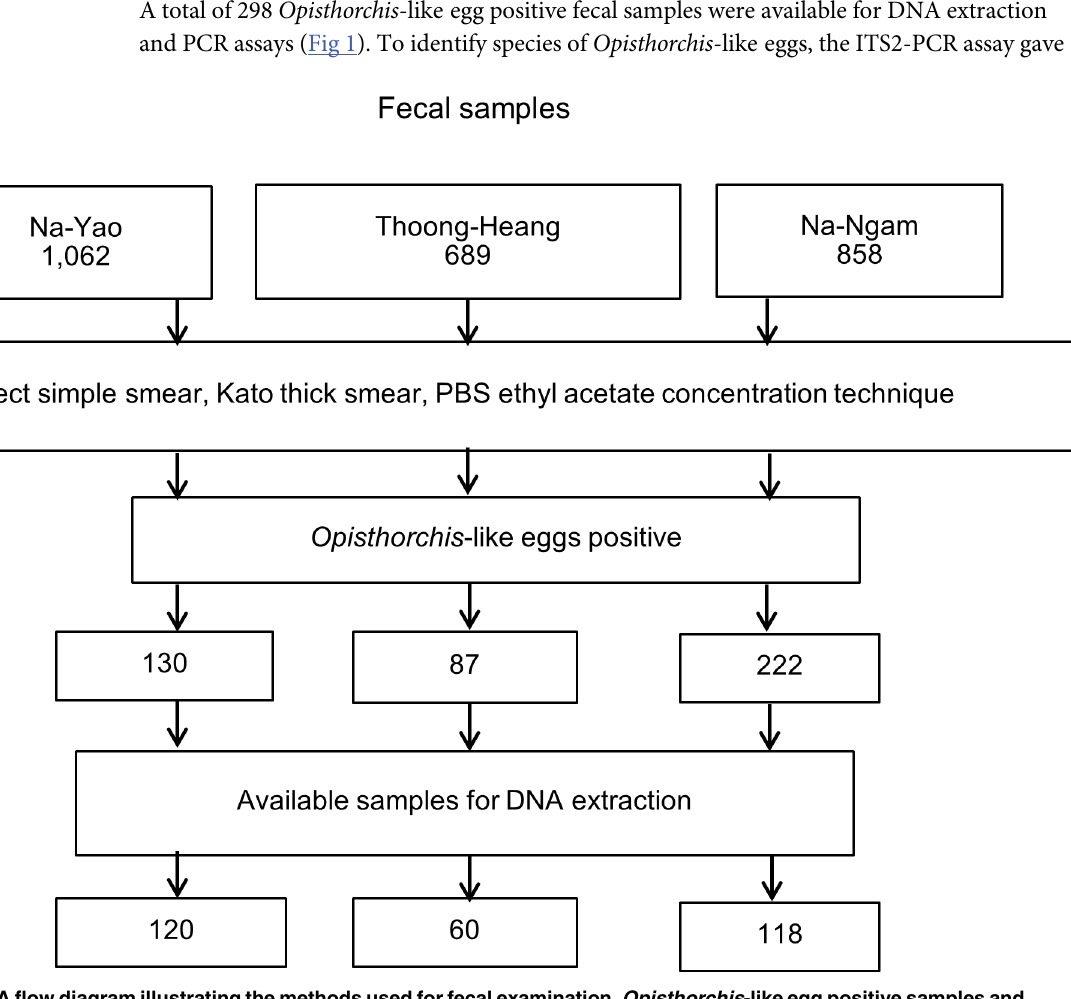
PLOS NeglectedTropical Diseases | https://doi.org/10.1371/journal.pntd.0006030 November2,